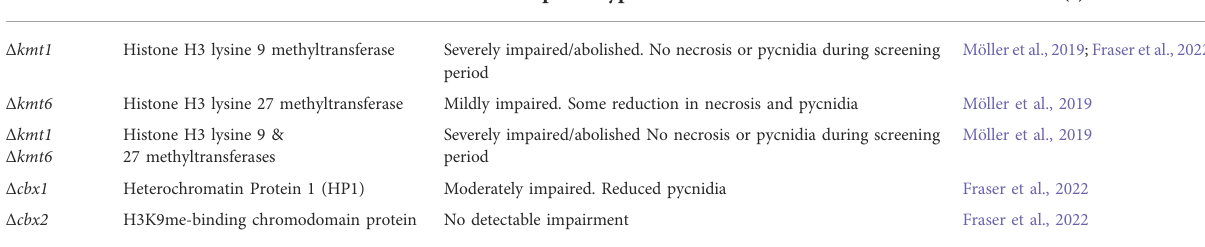
TABLE 1 Summary of the virulence phenotypes of Z. tritici heterochromatin